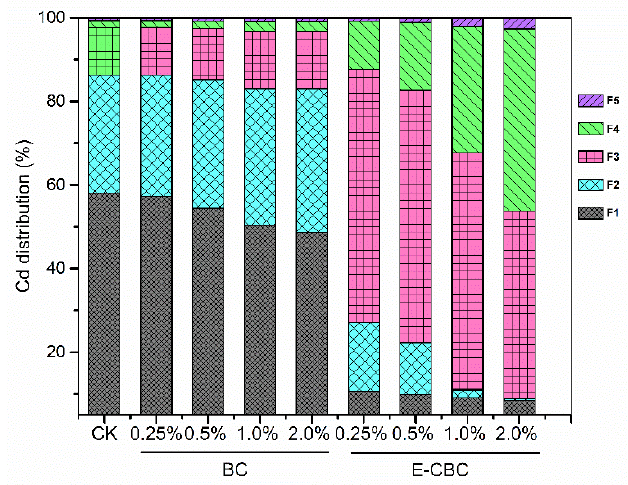
Figure 6. Effects of BC and E–CBC on speciation distribution of Cd in soil.